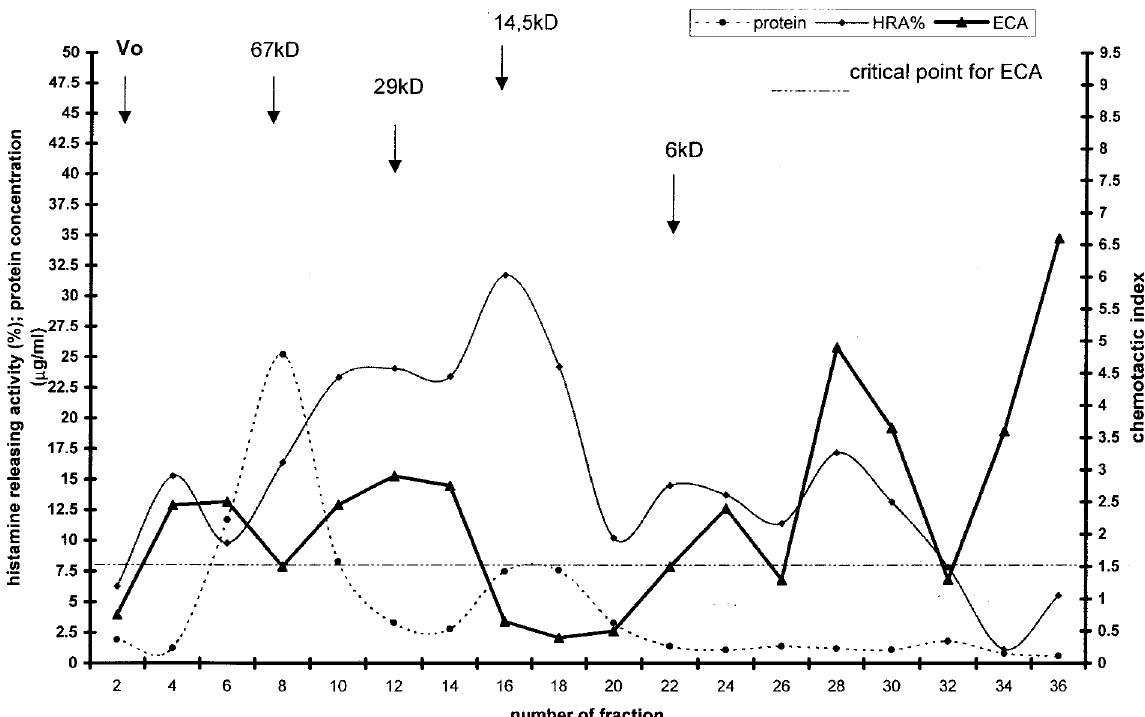
FIG. 3. Gel column chromatography analysis of ECA and HRA generated by mononuclear cells (MNC) from atopic patients (supernatants pooled from three